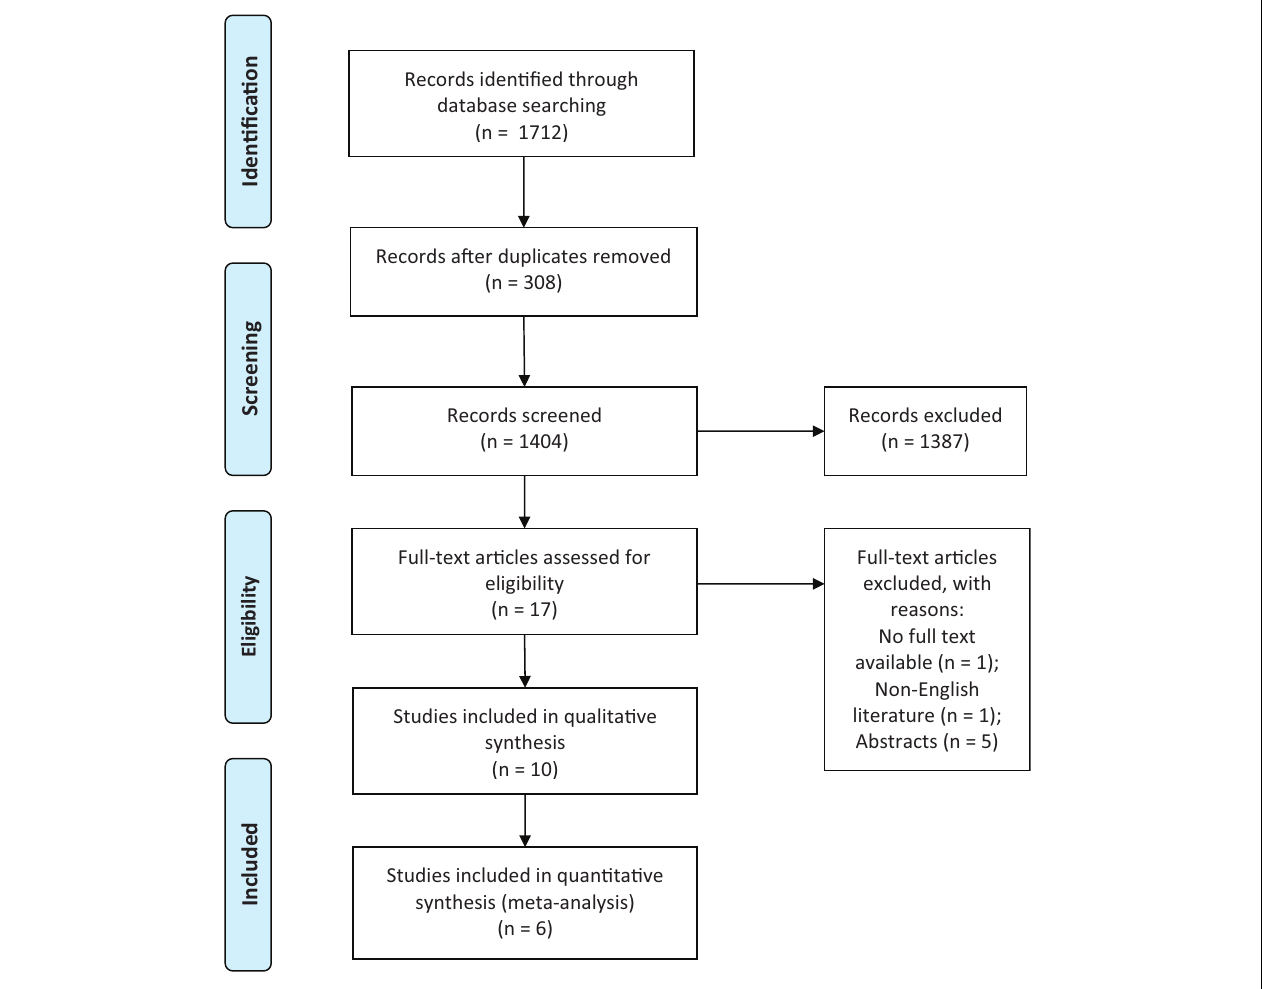
FIGURE 1 | Flow diagram of studies in the systematic